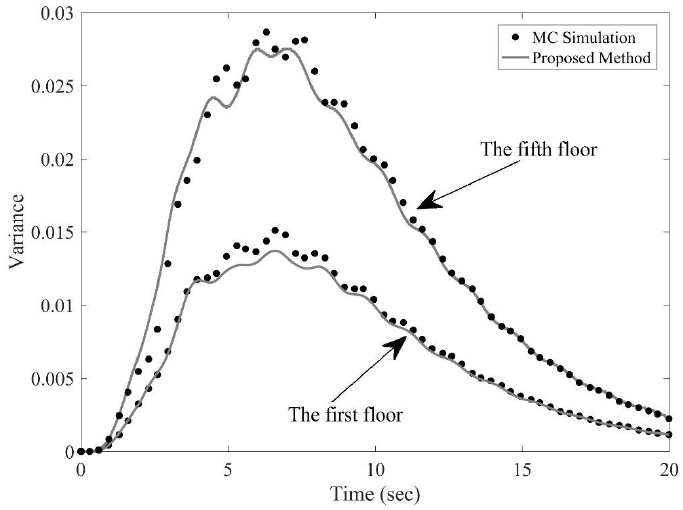
Figure 17. Mean square displacement response of a 5DOF Duffing–Van der Pol system under nonstationary excitation. ( γ = 10.0, µ = 10.0).